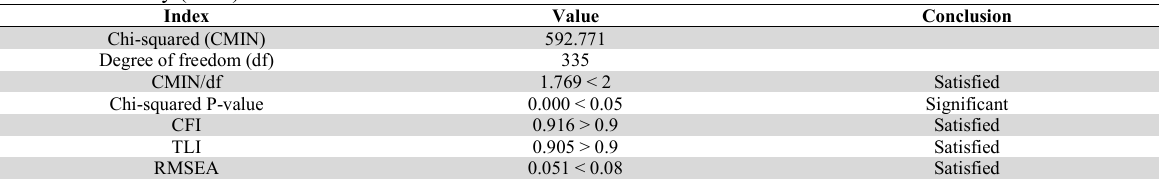
Model fit summary (CFA)